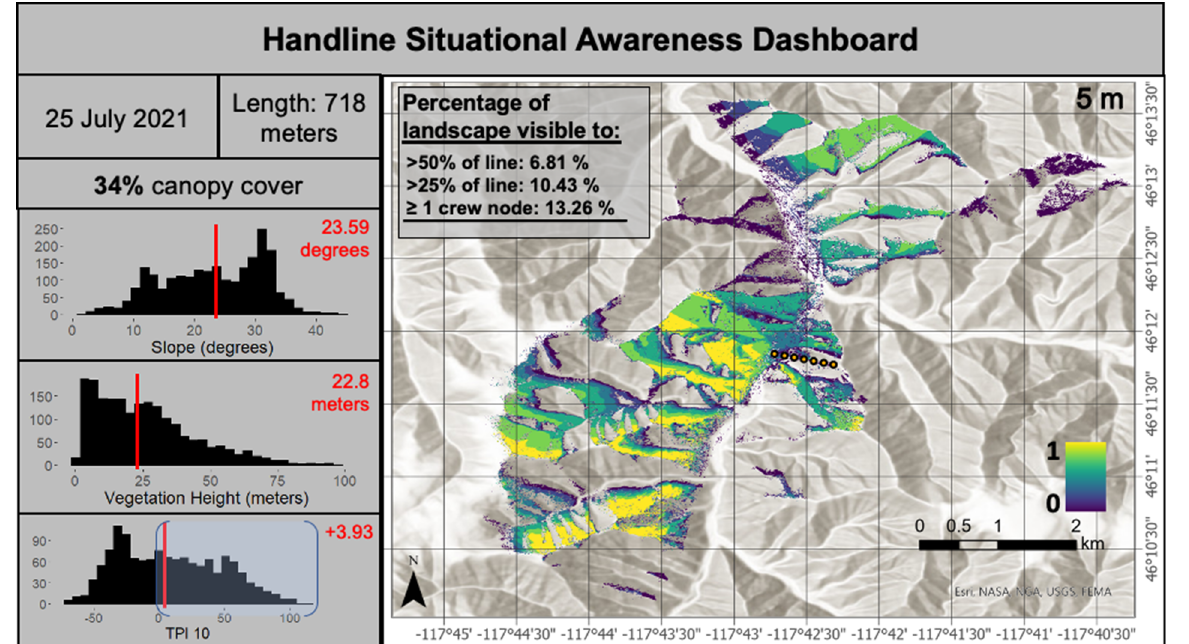
Figure 10. Mockup of a dashboard incorporating visibility, canopy cover, slope, vegetation height, and TPI. Blue brackets in overlaid on the TPI histogram highlight areas of higher elevation relative to the immediate surroundings.